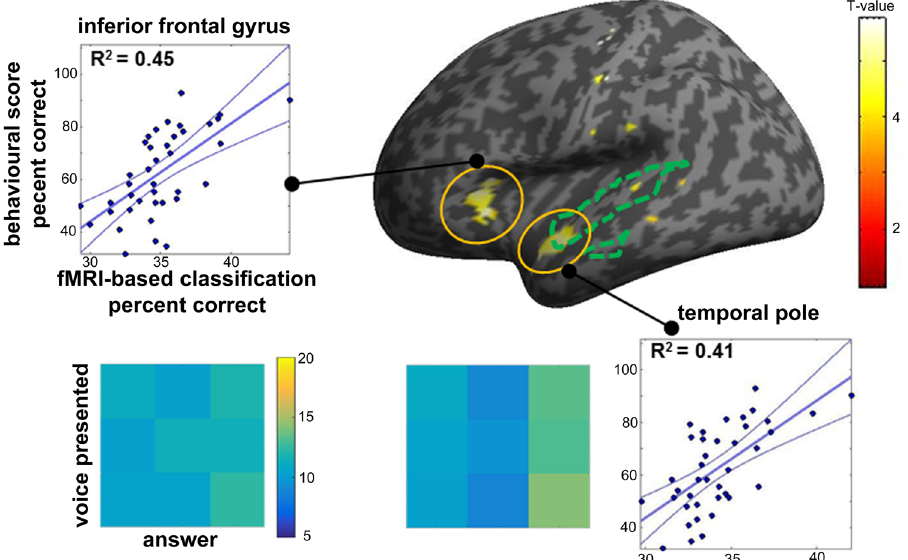
Figure 5. Correlation of speaker classification accuracy with individual speaker recognition scores. Co-variation of speaker classification accuracy with identification scores in voice sensitive regions was computed in a permutation-based regression model with one covariate. R 2 = coefficient of determination of Spearman correlation coefficient. Confusion matrices are sown with the same convention as in Fig. 2c. Green dashed lines indicate TVAs obtained in the sample (V > NV). The group statistical map at an uncorrected threshold ( p < 0.001) is here overlaid on an inflated render in SPM for illustration